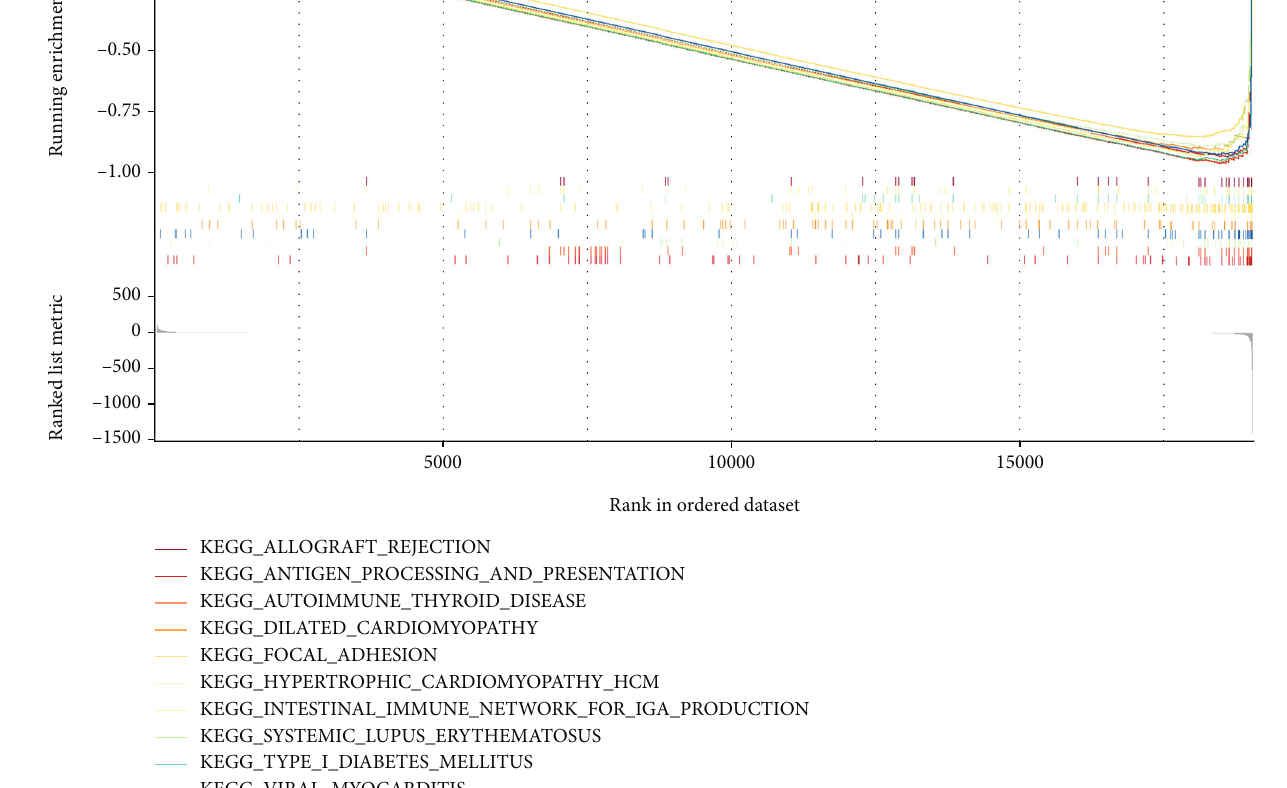
Figure 6: GSEA on samples with low FGFR3 expression and the enrichment of low FGFR3 expression in the C2